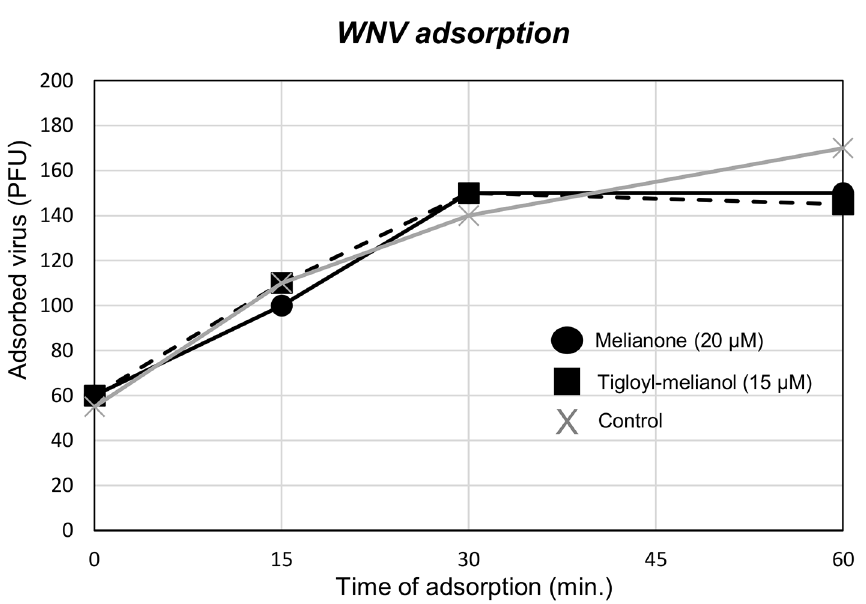
Fig 4. Effect of melianone and 3- α -tigloyl-melianol on WNV adsorption kinetic. BHK-21 cells were incubated during 0, 15, 30 and 60 min. at 4°C with WNV in the absence or presence of compounds. Each value represents a mean of duplicate assays. Treatment with both compounds doesn ’ t reduce the virus titre.